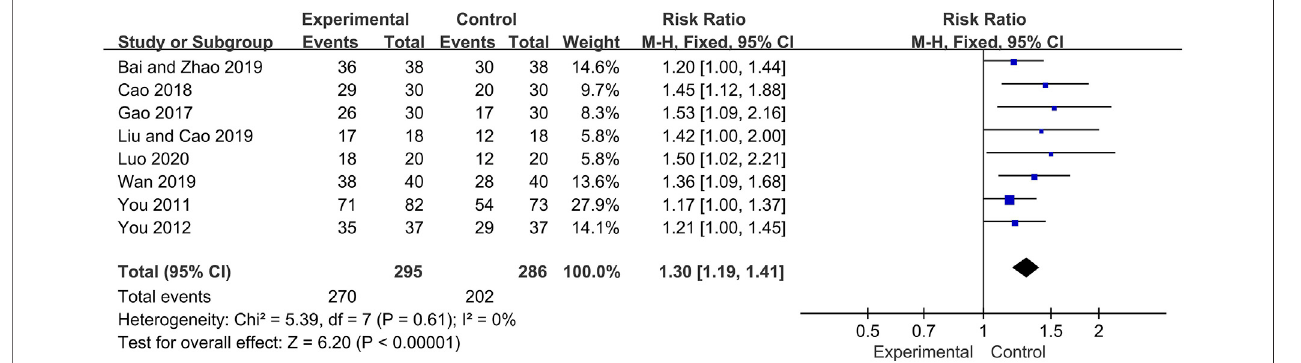
FIGURE 3 | Forest plot of the overall response rate.